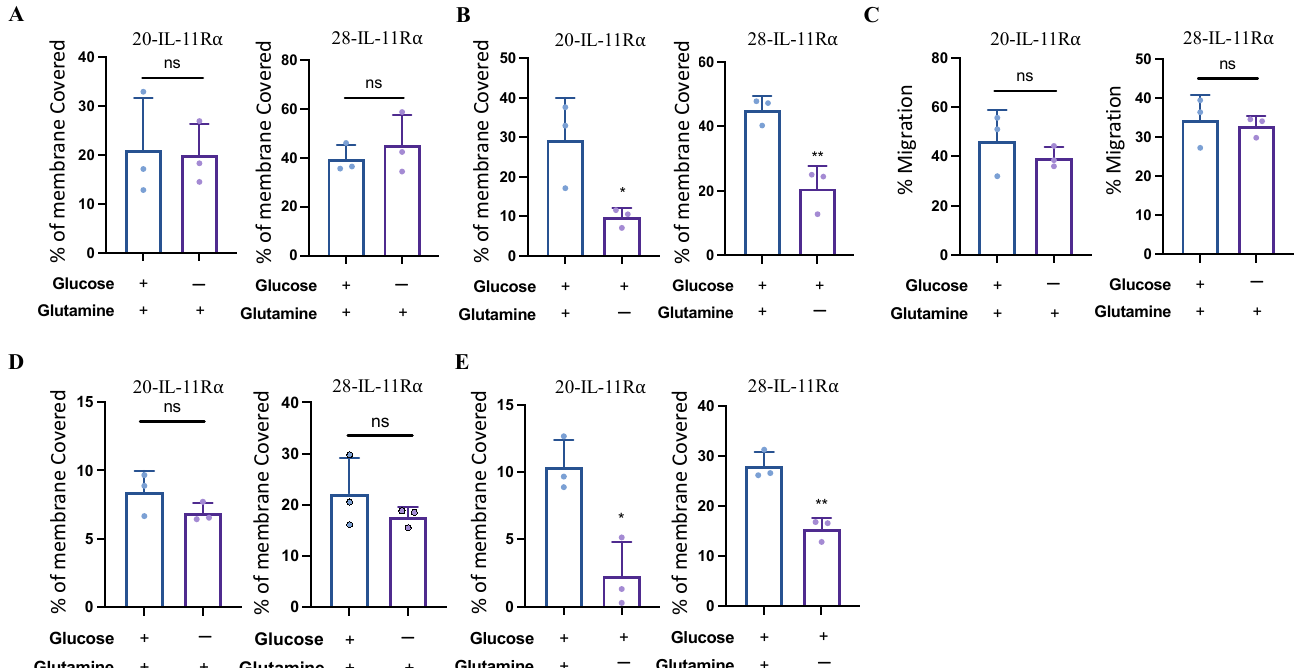
Figure 4. IL-11R α -driven migration and invasion is glutamine-dependent but glucose-independent. #20-IL-11R α and #28-IL-11R α cells were cultured in media ± glucose and ± glutamine as indicated. Cells were then assessed for ( A , B ) transwell migration (n = 3, mean ± SD, where ns indicates p > 0.05, * indicates p < 0.05 and ** indicates p < 0.01), ( C ) wound healing (n = 3, mean ± SD, where ns indicates p > 0.05) and ( D , E ) transwell invasion (n = 3, mean ± SD, where ns indicates p > 0.05, * indicates p < 0.05 and ** indicates p < 0.01).